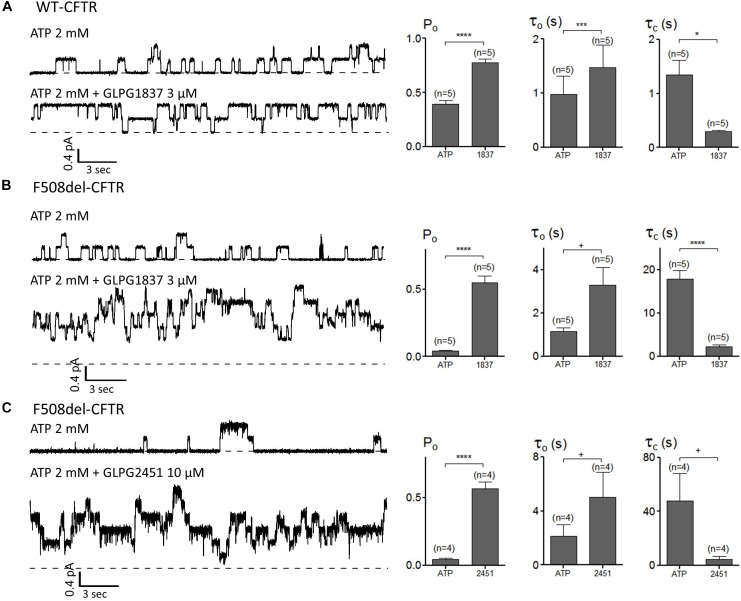
Patch clamp studies on excised patches using CHO cells showing the effect of GLPG1837 on (A) WT (Po, τo, and τc), (B) F508del (Po, τo, and τc) and of GLPG2451 on (C) F508del (Po, τo, and τc) CFTR. The statistical analysis of single-channel kinetic parameters was described in Materials and Methods, every condition was tested at least 4 times. ∗P < 0.05; ∗∗∗P < 0.005; ∗∗∗∗P < 0.001; +P > 0.05.